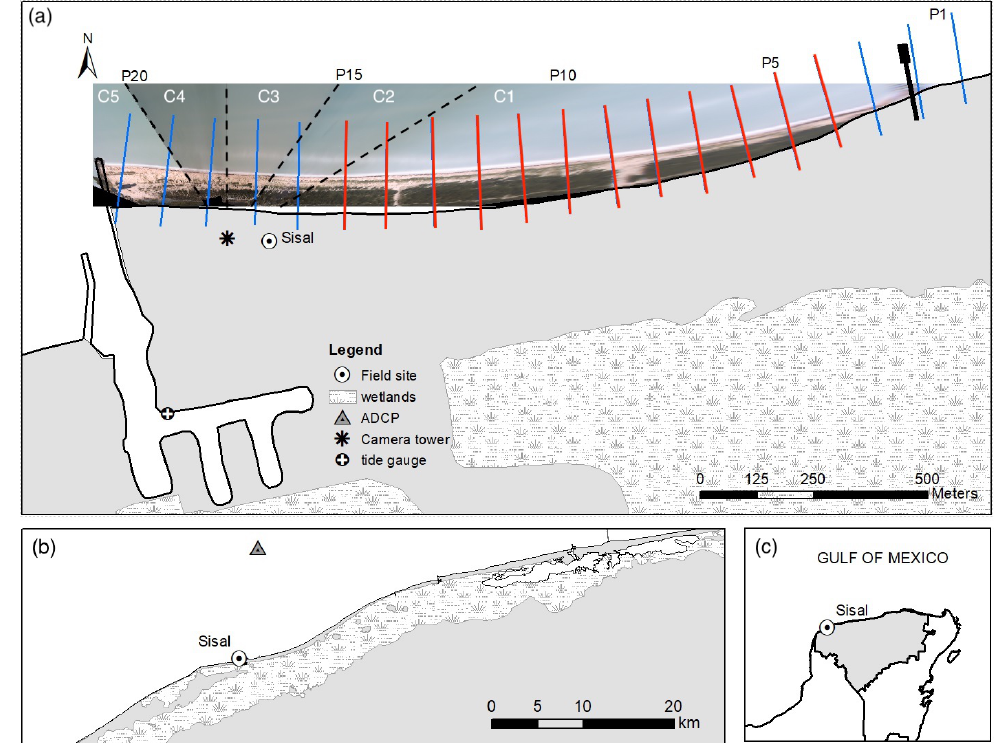
Figure 1. Study area showing the location of the camera tower in Sisal beach, the fields of view of the five cameras (C1 to C5), the surveyed beach profiles, tide gauge inside Sisal port ( a ), the ADCP location at 10 m depth ( b ), and the study location within the Gulf of Mexico ( c ). Only profiles 4–15 (red lines) that correspond to C1 are used in this